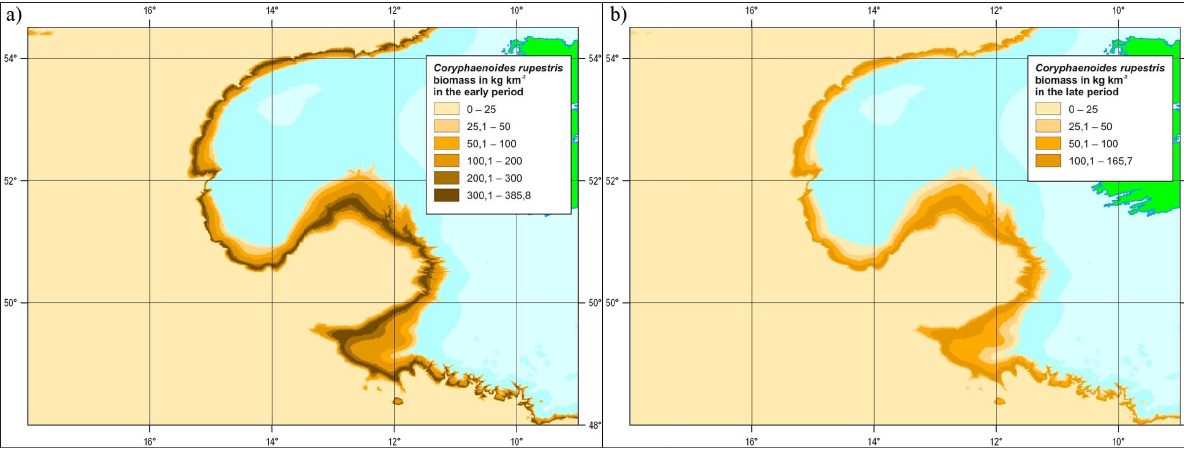
Fig. 5. The GIS predicted model of spatial distribution for biomass (kgkm − 2 ) of the main target commercial fish species, roundnose grenadier Coryphaenoides rupestris in ICES Sub-area VII (Divisions b, c, j, k) based on the fitted models in Fig. 4b. for (a) the early (1977–1989) and (b) the late (2000–2002)